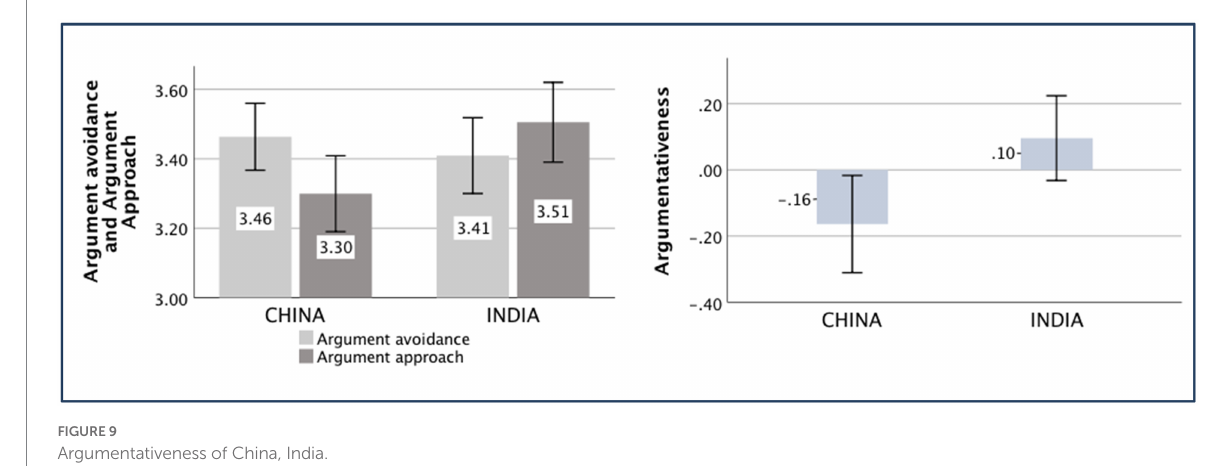
FIGURE 9 Argumentativeness of China, India.